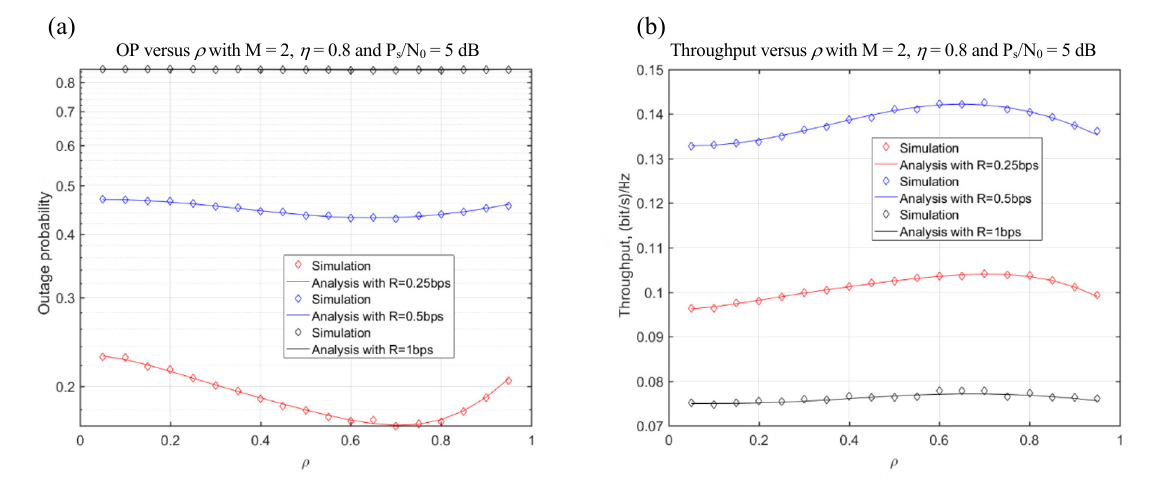
Fig. 3. Outage probability (a) and achievable throughput (b) versus the power splitting factor ρ .